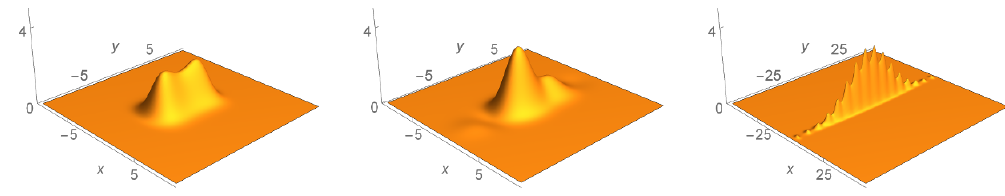
Figure 5 . Mass density pro(cid:12)le m ( x; y ) = exp( R + (cid:15) (cid:14) R ) for black bars perturbed by zero modes. From left to right: perturbations with n y = 4 ; 5 ;